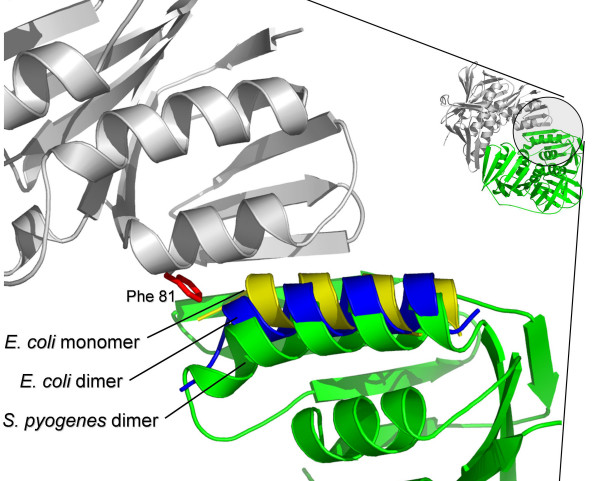
Differences in helix α1" geometry between in E. coli and S. pyogenes β. The dimeric interface of both β clamps distort of this helix (E. coli in blue, S. pyogenes in green). In the monomeric form of β (shown in yellow) crystallized bound to the δ subunit of the clamp loader [18], this helix is straight. The other protomer of S. pyogenes β is shown in grey for reference, with the sidechain of Phe81 shown in red. Figure rendered with with PyMol (DeLano Scientific).